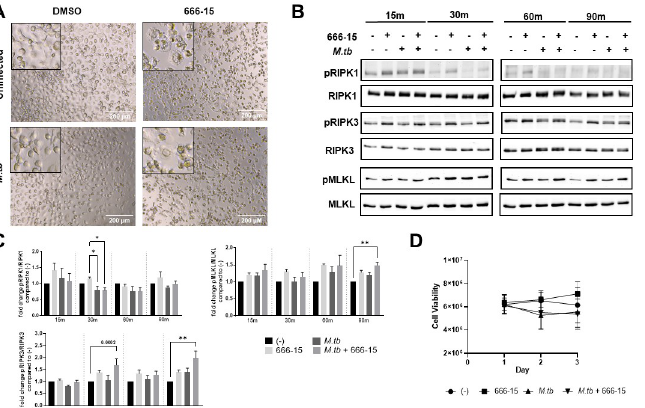
Fig 6. CREB inhibition induces activation of the necroptotic signaling pathway in M . tb -infected macrophages, but does not affect cell viability. MDMs were pretreated with 666–15 or DMSO control for 60 min and subsequently infected with M . tb H 37 R v at MOI 2 (A,D) or MOI 10 (B,C). A) Bright field images of the cells were taken at 40x; Data shown are representative of n = 10 donors. B,C) Cell lysates were collected and probed by WB blot for the indicated phosphorylated and total proteins. Densitometry was determined and graphed as fold change ± SEM of phosphorylated protein to total protein; A representative experiment is shown and graphed data are cumulative of n = 4 donors. One-way ANOVA with Tukey’s post-test. D) Membrane integrity and cell viability was determined by Cytotox Glo assay. Data are cumulative ± SEM of n = 3 donors. Two-way ANOVA with Tukey’s post-test; * p < 0.05, ** p < 0.01, *** p <